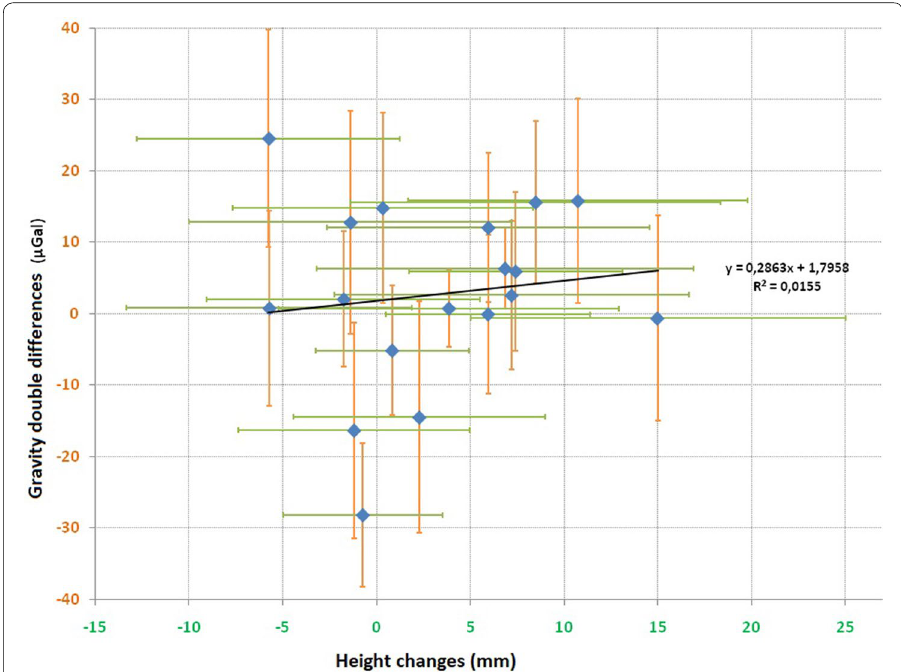
Fig. 5 Gravity double differences (in µGal) as a function of height changes (in mm) in 2015 and 2017 com‑ pared to 2014 with their errors. The coefficient of determination is equal to 0.0155